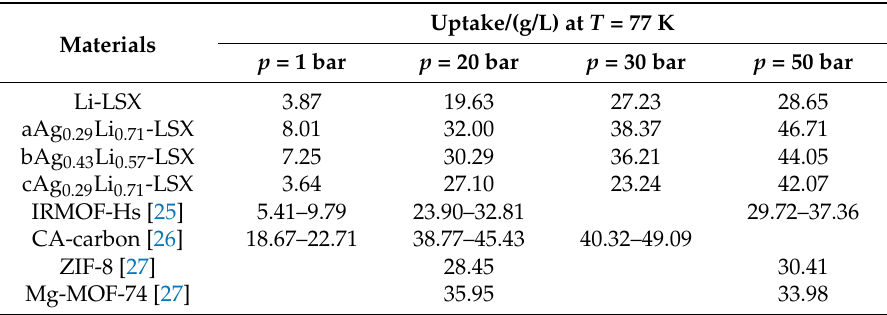
Figure 10. Metropolis Monte Carlo (MMC) simulated adsorption isotherms of H 2 volumetric uptake by Li-LSX and Ag-exchange Li-LSX in comparison at 77 K. The inset specifies the H 2 uptakes in pressure range of 0.0–1.0 bar. Table 3. H 2 uptakes in newly reported porous materials for comparison.